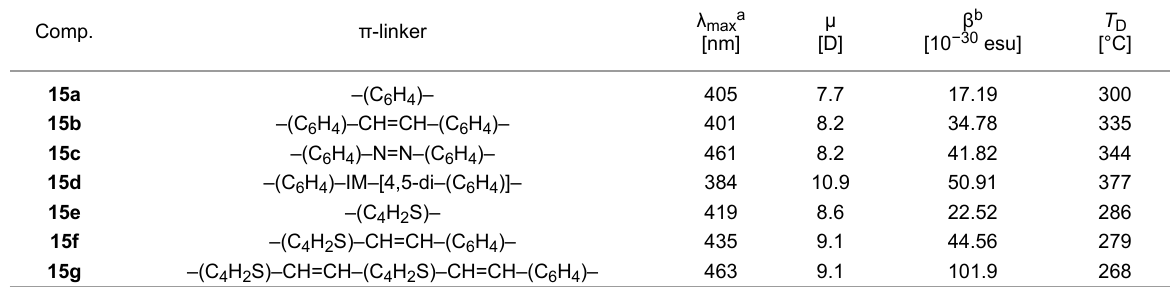
Table 4: Properties of 4,5-bis(4-aminophenyl)imidazole-derived chromophores 15a – g [16,17,47].